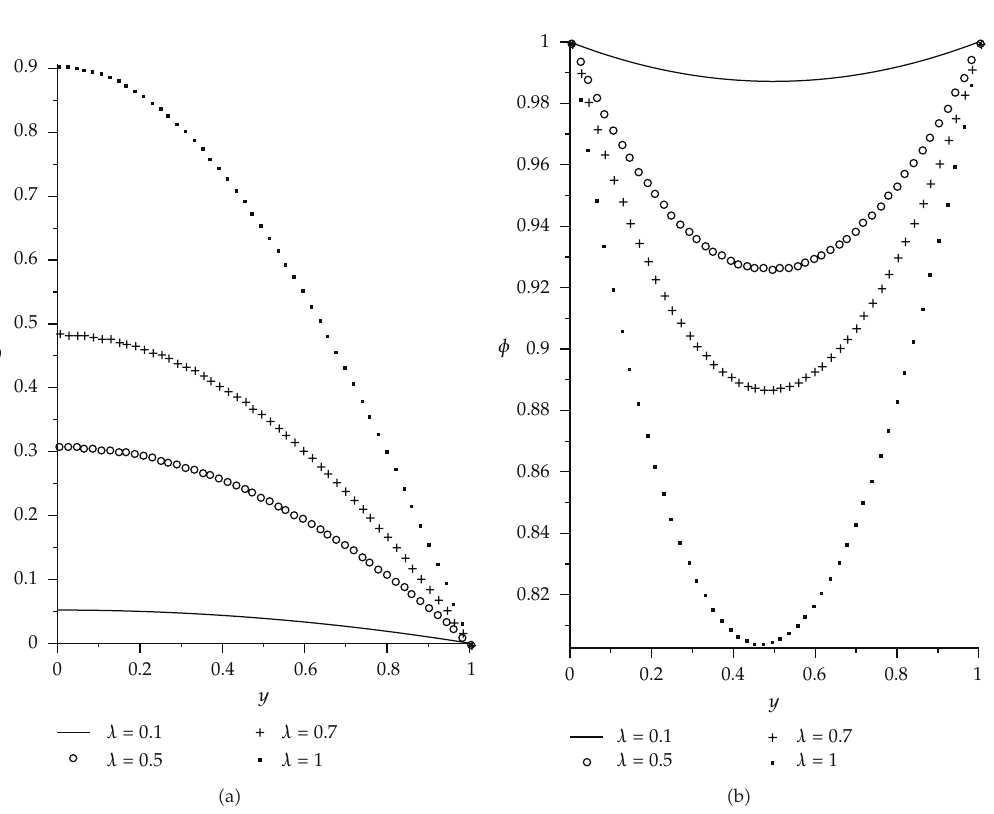
Figure 8: Temperature and oxygen concentration profiles for m (cid:8) 0 . 5 , n (cid:8) β (cid:8) 1 , θ w (cid:8) 0 , ε (cid:8)